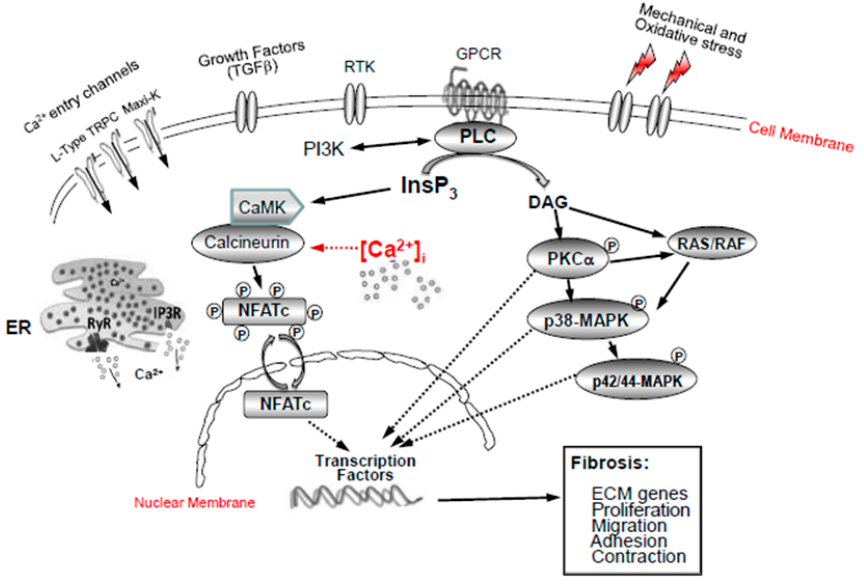
Figure 4. Ca 2+ signalling pathways in activated lamina cribrosa fibroblasts in glaucoma. Mechanical and oxidative stress and growth factors (TGF β ) stimulate Ca 2+ ion channels (L-type, TRPC, Maxi-K + ) and intracellular Ca 2+ release from internal stores (ER and mitochondria). This stimulates PLC,